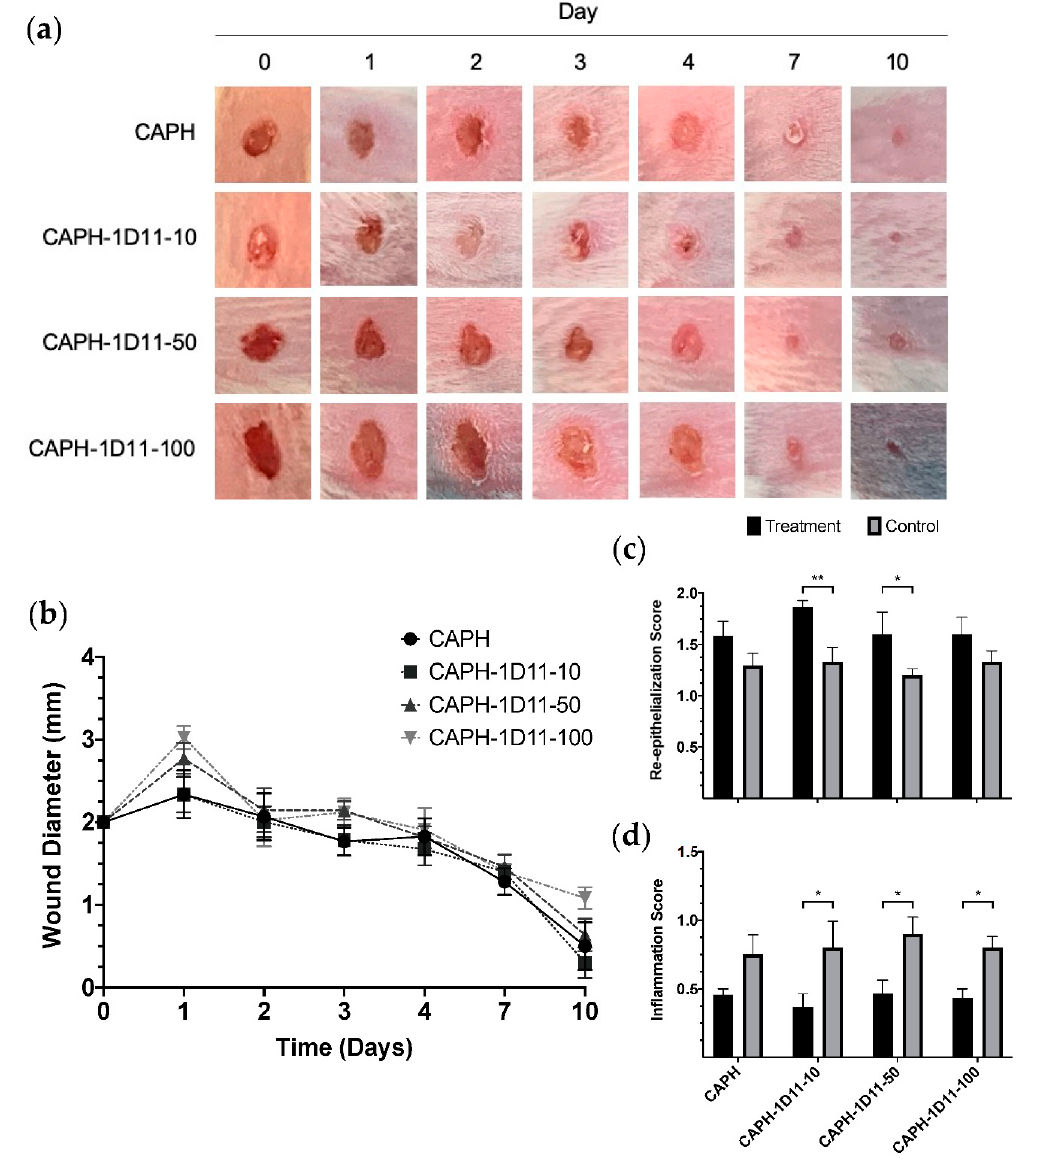
Figure 2. Wound contraction and assessment in response to application of Ca-alginate-PEGMA hydrogels with and without pan-specific anti-TGF- β mouse monoclonal antibody 1D11.16.8, evaluated over ten days. ( a ) Representative photographs of excisional wounds before and after application of Ca-alginate-PEGMA hydrogel (CAPH) loaded without or with 10, 50, and 100 µ g anti-TGF- β antibody (CAPH-1D11-10, CAPH-1D11-50, and CAPH-1D11-100, respectively), evaluated over 10 days. ( b ) Comparison of wound size over 10 days with initial wound size being 2 mm for all groups. Graphic presented as the mean of wound diameter size in mm ± SEM, n = 5/group. ( c ) Epithelization. ( d ) Inflammation score of mice treated with CAPH with and without anti-TGF- β antibody. A four-point score was used (with 0 score (none), 1 score (scant), 2 score (moderate), and 3 score (abundant)), and is presented as a mean ± SEM. n = 5/group. Significance is denoted as * p < 0.05 and ** p < 0.01.